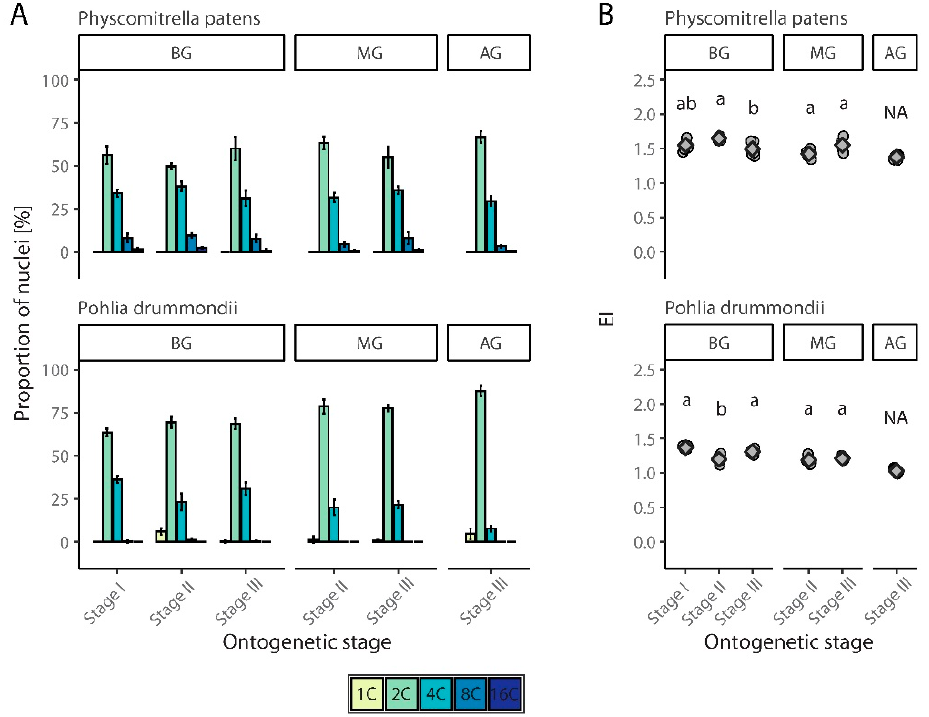
Figure 5. Spatial and temporal endopolyploidy pattern in cultivated moss species, Physcomitrella patens and Pohlia drummondii . ( A ) Percentual distribution (mean ± SD) of different categories of nuclei of studied mosses gametophyte in three ontogenetic stages. ( B ) Jitter plot with mean ± SD for endoreduplication index (EI) values of studied moss species. BG, basal part of gametophyte; MG, middle part of gametophyte; AG, apical part of gametophyte. Homogenic groups revealed by ANOVA (or t test in case of MG) and Tukey’s HSD test are denoted by lower case letters. NA, not applied.